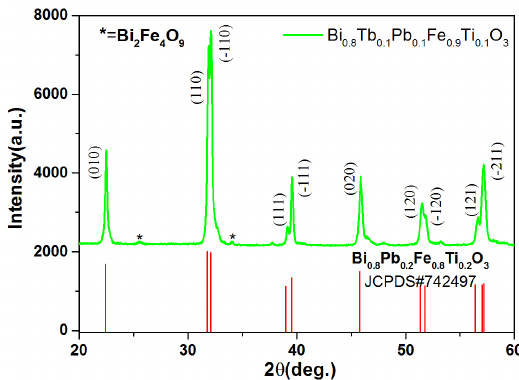
Fig. 1 Room temperature XRD patterns of Bi